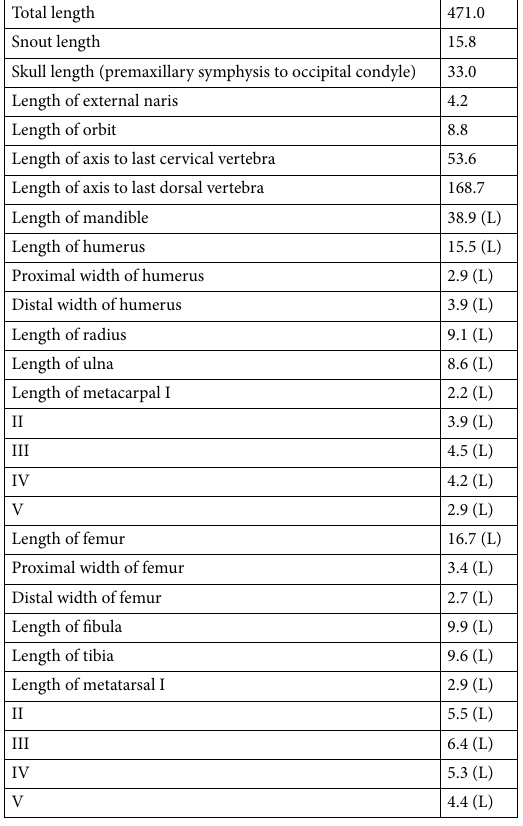
Table 1. Measurements (in mm) of the holotype (IVPP V30380) of Honghesaurus longicaudalis gen. et sp. nov. L,